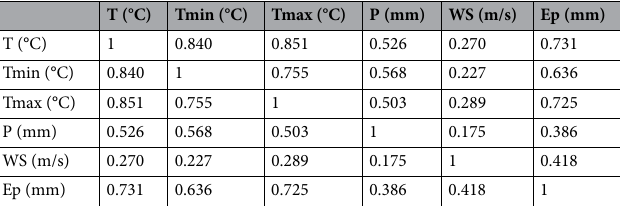
Table 3. The Kendall correlation coefficient between meteorological variables and